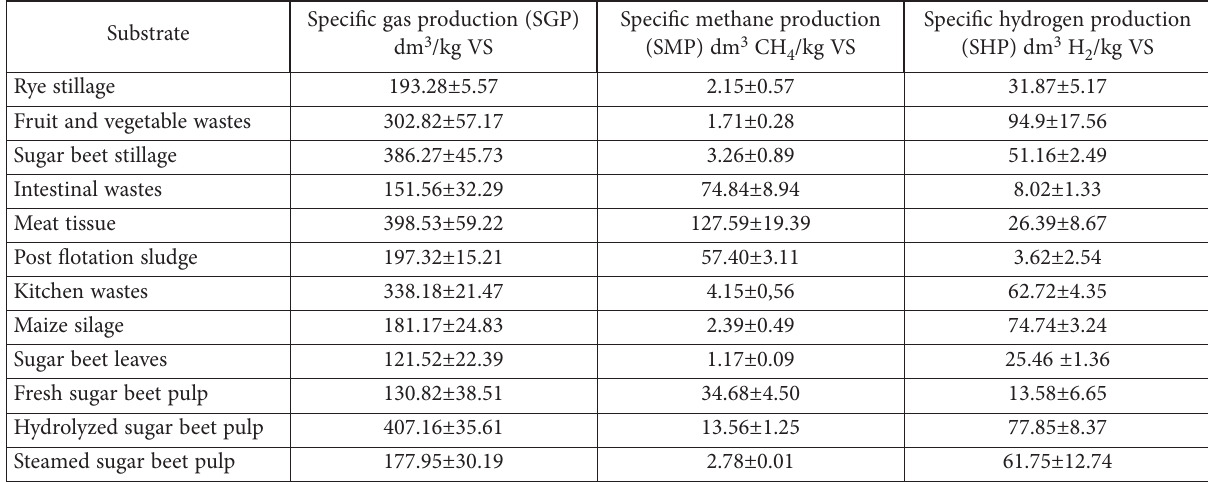
Table 4. Parameters of the batch digestion tests with pH adjustment